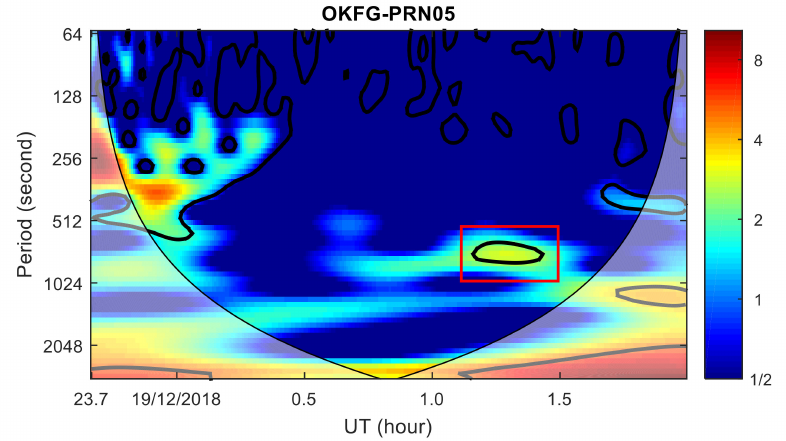
Figure 10. Wavelet transform power spectrum of TEC time series at OKFG station. Shadow region regions on either end indicate the “cone of influence”, where edge e ff ects become